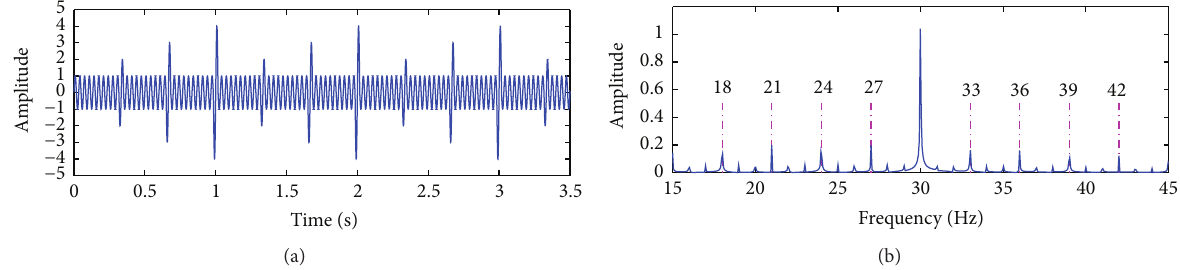
Figure 2: A simulation signal. (a) Time-domain waveform; (b) frequency